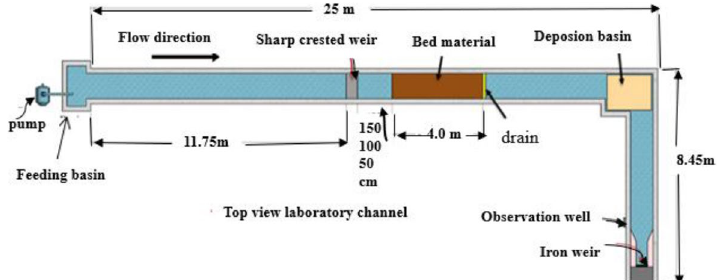
Fig. 2 Details of the channel